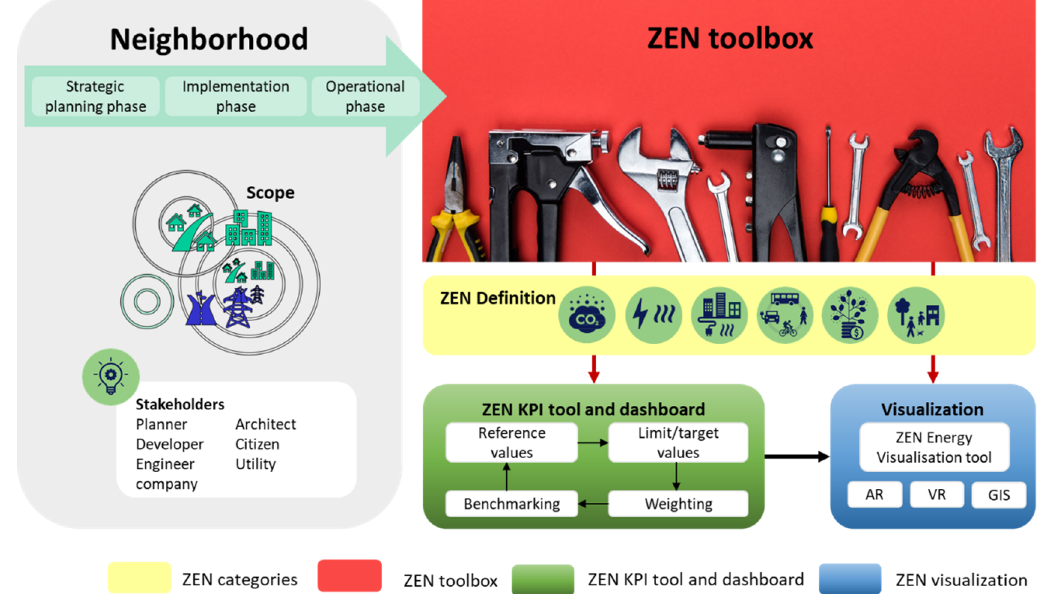
Figure 2. ZEN Toolbox. Reprinted with permission from Wiik, Fjellheim et al. [4]. AR = augmented reality; VR = virtual reality; GIS = geographic information system.